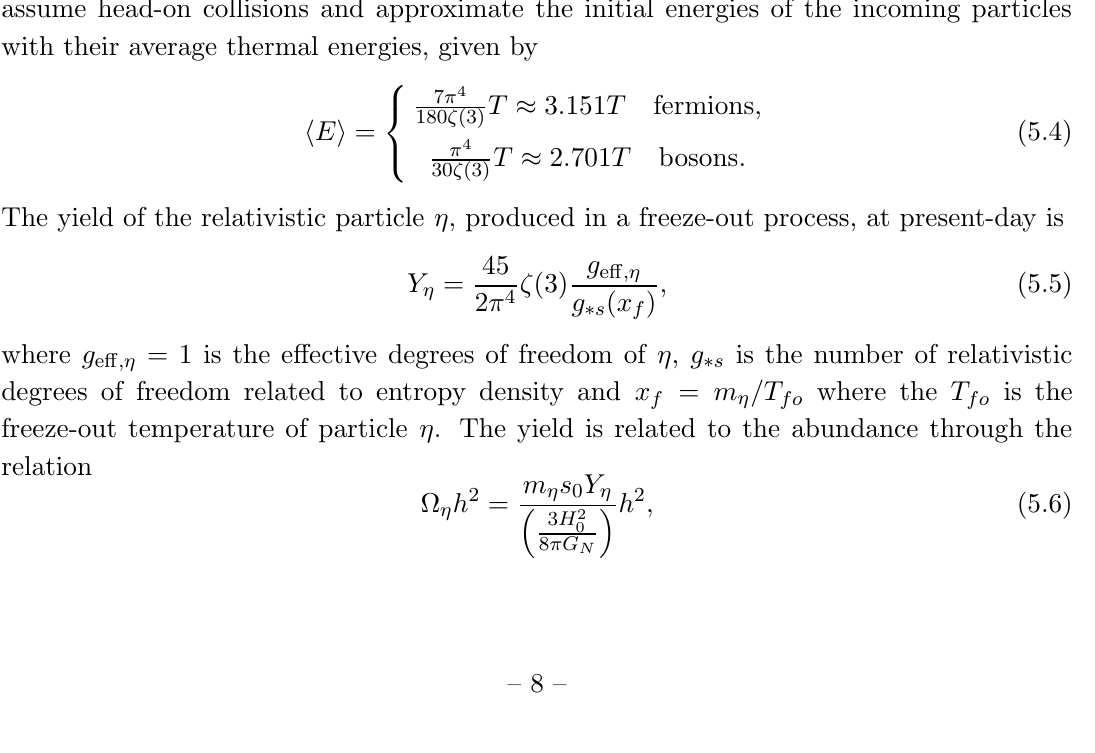
Figure 3 . The most important number changing diagrams for (cid:17) in the early universe. When T (cid:29) m , the thermally averaged cross section scales as h v(cid:27) (cid:11) Hence the interaction rate n h (cid:27)v i scales as T , while the Hubble rate scales as T 2 as a function of the temperature. Therefore, in this relativistic regime, the interaction rate becomes faster compared to the Hubble rate as the universe expands and the temperature